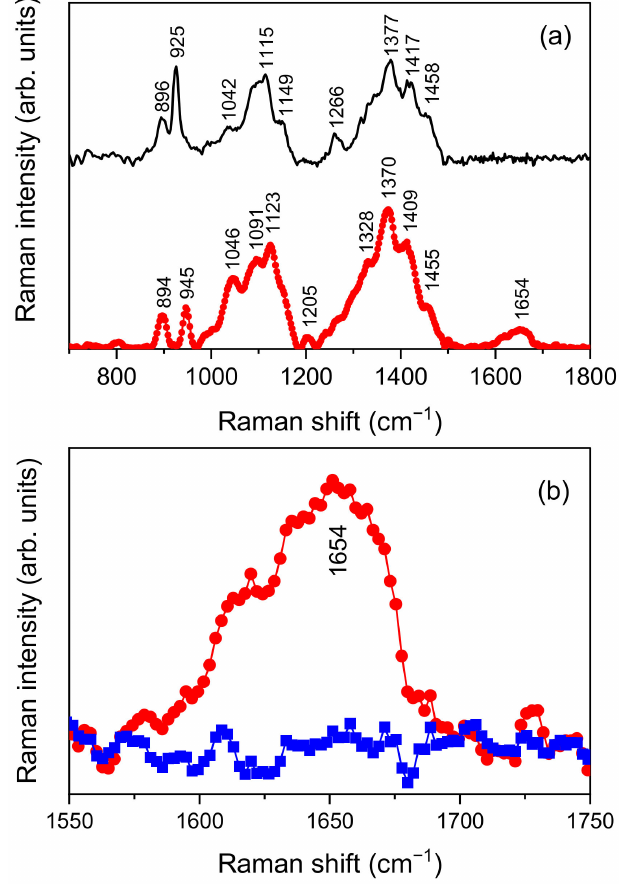
Figure 4. ( a ) µ -Raman experimental spectra, in the 700–1800 cm − 1 range, of HY (red circles) and CS (black line). ( b ) Comparison, in the 1550–1750 cm − 1 range, of the Raman experimental spectra of HY (red circles) and CS/HY NP systems (blue